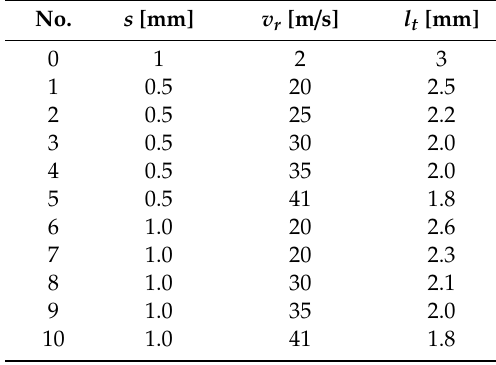
Table 4. The dependence of the width of the cut, on the relative speed of the Transfer Object (TO), and on the thickness of the metal band. Table 5. The dependence of the R a , on the working current, on the thickness of the metal band, and on the v a of PO.